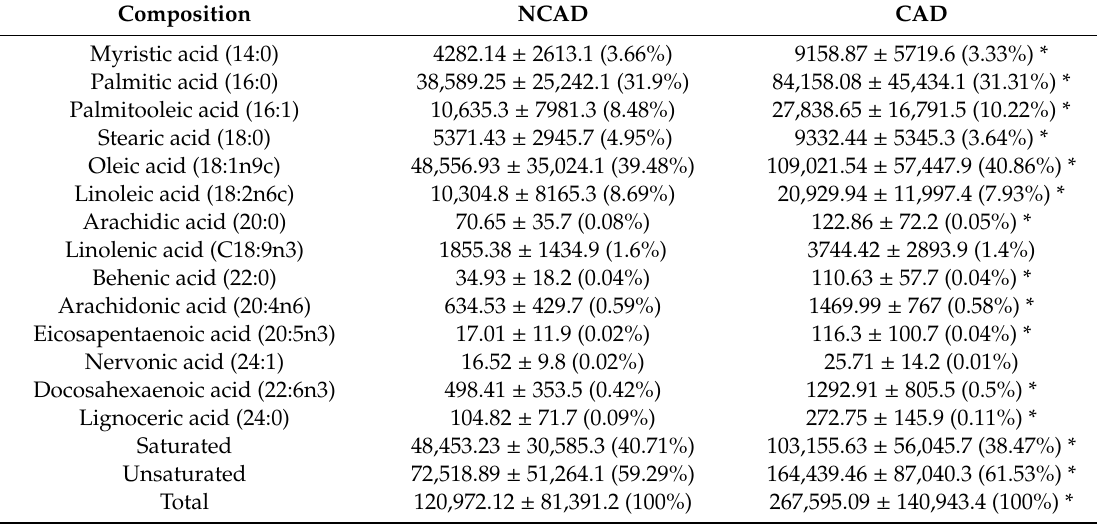
E ff ects of coronary atherosclerosis on myocardial triacylglycerol content and FA composition (mean ± SEM, n = 11 per NCAD group, n = 24 per CAD group). ∗ Di ff erence versus NCAD group ( p < 0.05). Values are expressed in nmol / g of wet tissue and show the percentage share of the FA in relation to the total TG